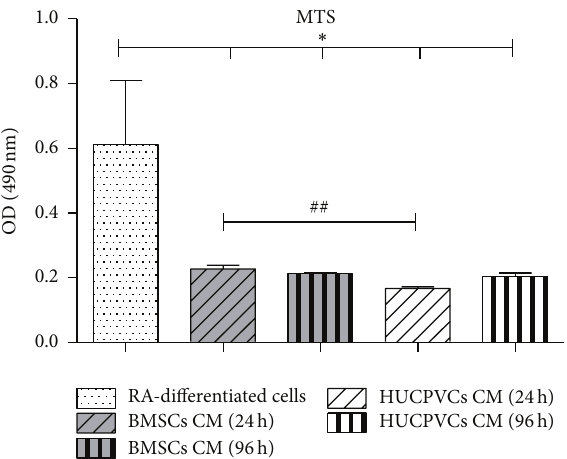
Figure 2: Cell densities for MAP-2 positive cells presenting neurites seven days after incubation with BMSCs and HUCPVCs